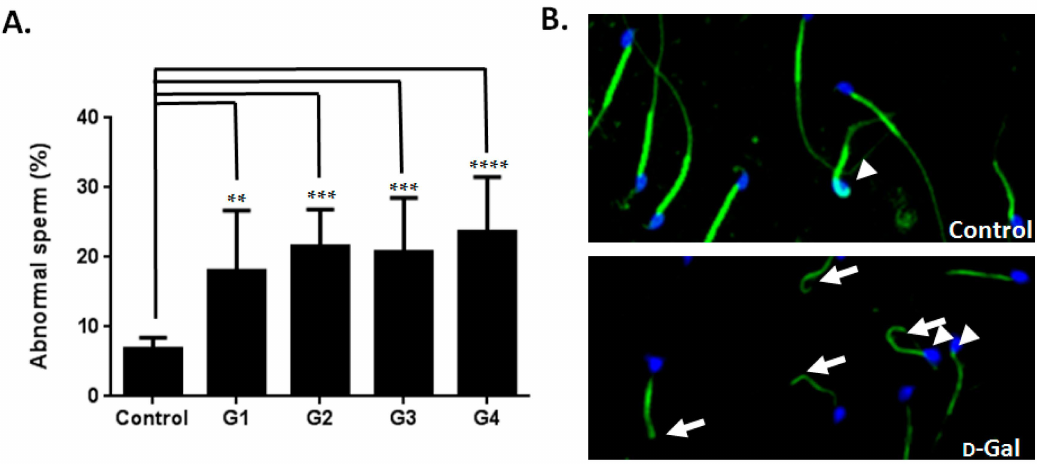
Figure 4. Effects of D -Gal injection on mice (II) ( A ) D -Gal-injected mice showed increased abnormal sperm morphology (%) compared to the control group. One-way ANOVA test: bars represent the mean ˘ SD; ** p < 0.01; *** p < 0.001; **** p < 0.0001; ( B ) Increased abnormal sperm morphology (%) (arrow: sperm with tail defects; arrowhead: head defects) from mice injected with D -Gal (bottom) compared to those administered PBS. 4,6-diamidino-2-phenylindole (DAPI): blue; Mito Tracker: green (magnification: ˆ